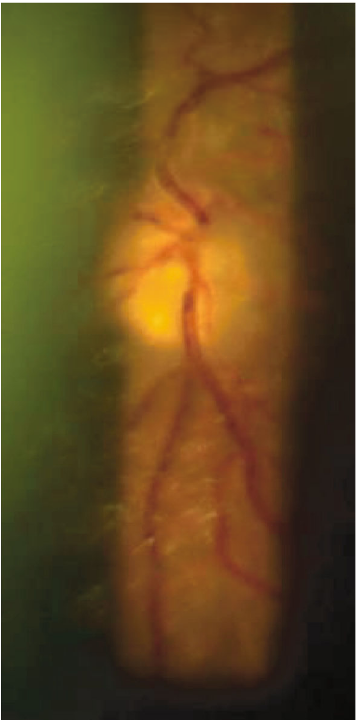
Figure 3: Blurred disc margin with chorioretinal folds in the left eye.